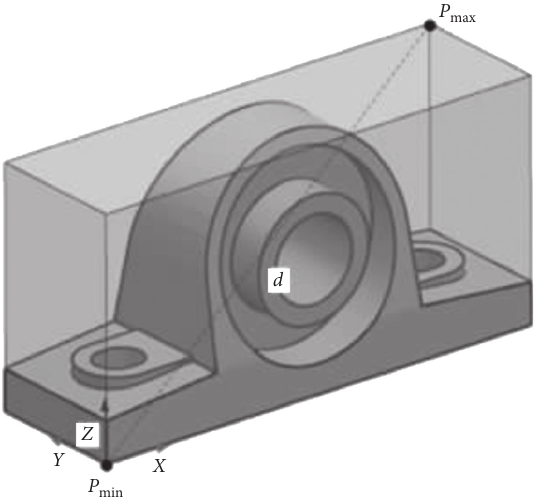
Figure 4: Calculation of the diagonal length of the bounding